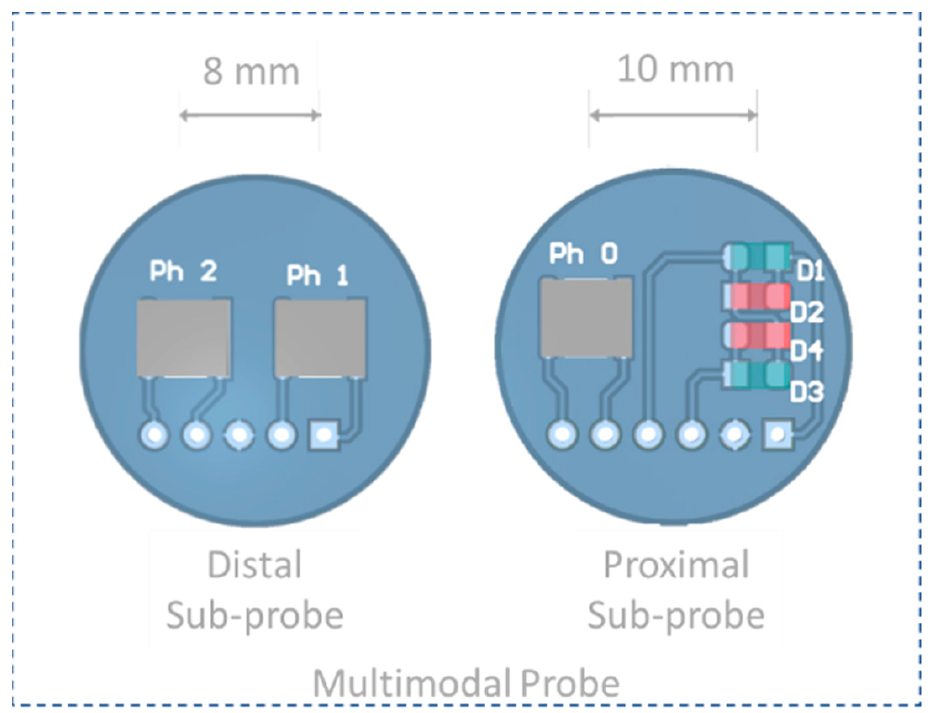
Figure 1. PCB design of the multimodal probe showing both proximal and distal sub-probes, with their respective optical components.